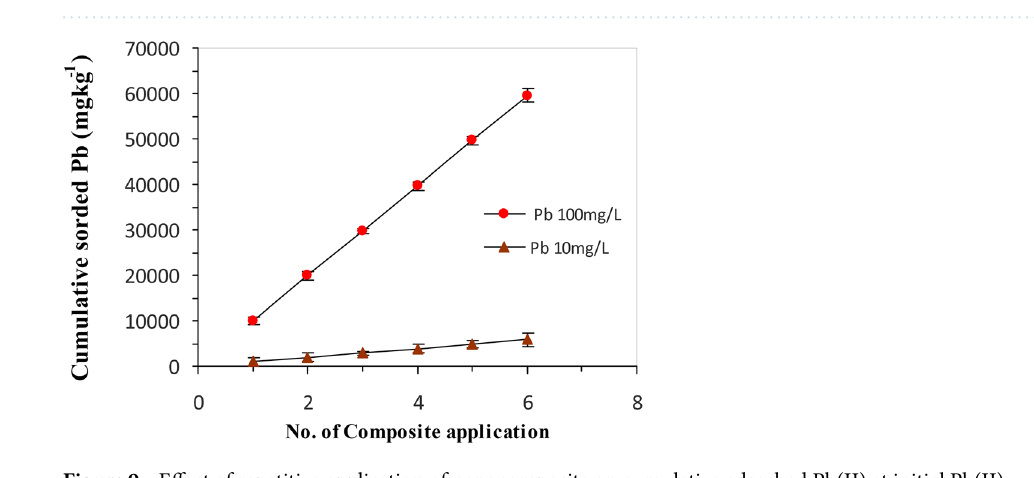
Figure 8. Arrhenius plot of Pb(II) adsorption on nanocomposite (T = 287, 297, and 307 K; pH 4, 7, and 9; Pb concentrations = 100, 250, 500 and 1000 mg L −1 ).